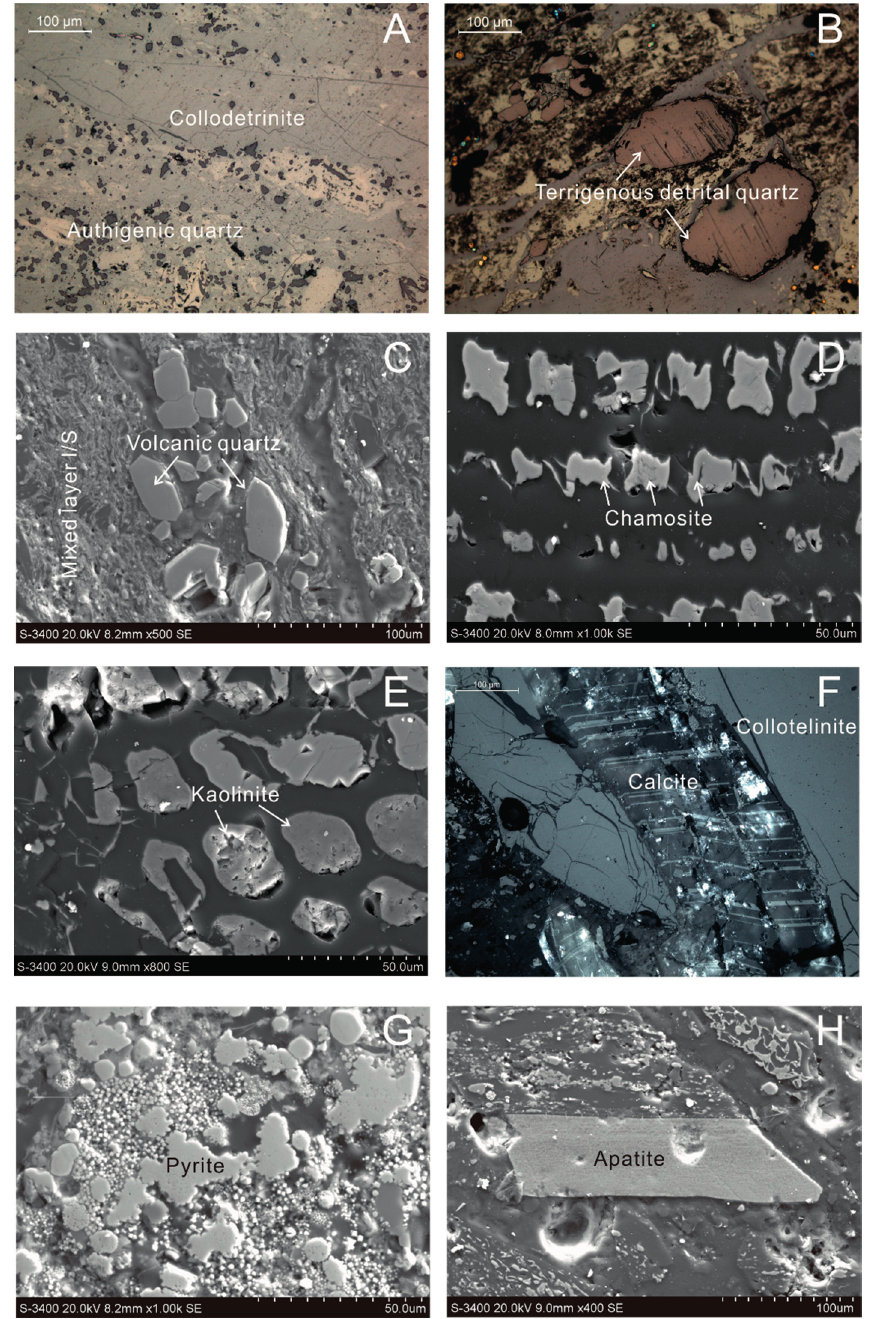
Figure 3. Minerals in the Mahe coals. ( A ) Disseminated irregular quartz particles in collodetrinite in the sample MhC2 (reflected light); ( B ) euhedral quartz in the sample MhC2 (reflected light); ( C ) β -form quartz of silicic volcanic ashes origin in the sample MhC2 (SEM, secondary electron image); ( D ) chamosite as cell-infillings in the sample MhC2 (SEM, secondary electron image); ( E ) kaolinite as cell-infillings in the sample MhC5a (SEM, secondary electron image); ( F ) calcite veins in the fractures of collotelinite with the twin-striation characteristics under crossed polarized light in the sample MhC2 (reflected light, oil immersion); ( G ) pyrite as disseminated or framboidal particles in the sample MhC2 (SEM, secondary electron image); ( H ) euhedral apatite in the sample MhC2 (SEM, secondary electron